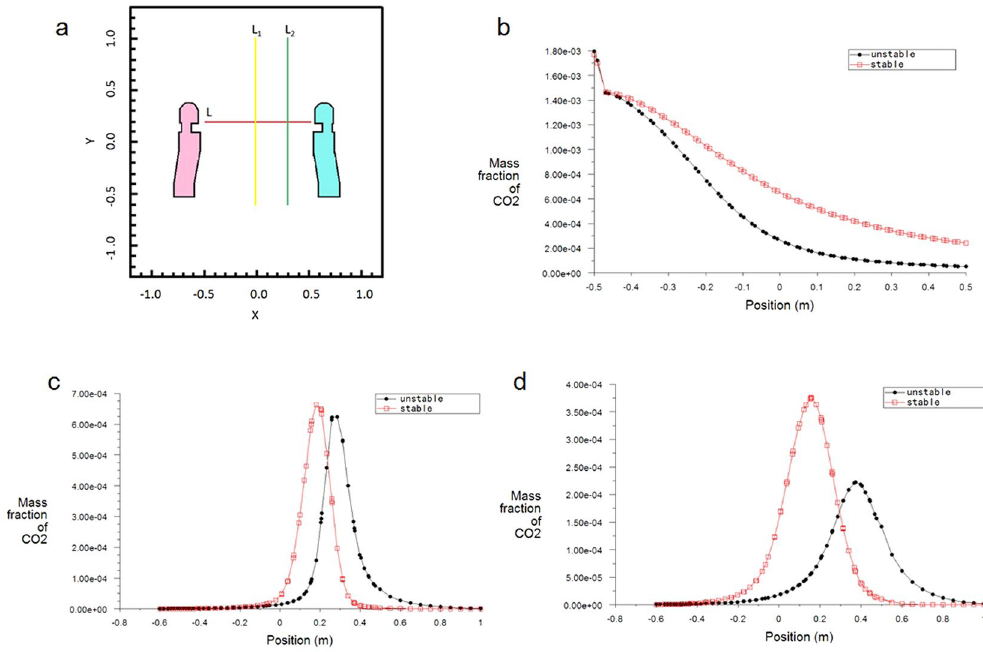
Figure 4. The characteristic of smoke concentration distribution in the dispersion direction under unstable case and stable case when t = 10 s. ( a ) Location map of manikins formed on the section of z = − 0.45 m, ( b ) line graph along line L in a , showing that after a certain distance away from the mouth, the CO 2 concentration in stable case is always higher than that in unstable case; ( c ) line graph along line L 1 in a , showing that pollutants in unstable case continues to spread to the upper space, and a more obvious upward movement in Y direction; ( d ) line graph along line L 2 in a , showing that in stable case, pollutants have a slight downward movement